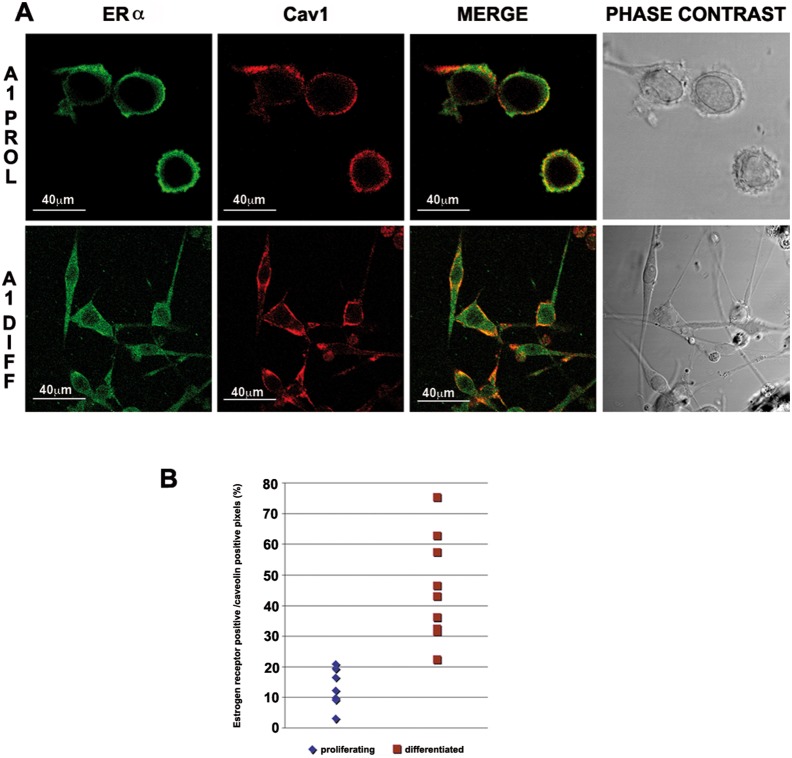
Co-localization of Cav1 and ERα on A1 cell membrane increases upon differentiation.(A) Immunofluorescent detection shows a partial co-localization of ERα and Cav1 in A1 cells proliferating/undifferentiated (A1 prol.) and non-proliferating/differentiated (A1 diff.). (B) The analysis of Z0 images of confocal stacks, acquired from different fields of proliferating and non-proliferating A1 cells, shows a higher percentage of co-localization of ERα and Cav1 in plasma membranes of the differentiated cells compared to proliferating/non-differentiated cells. Scale bar equal 40 µm.